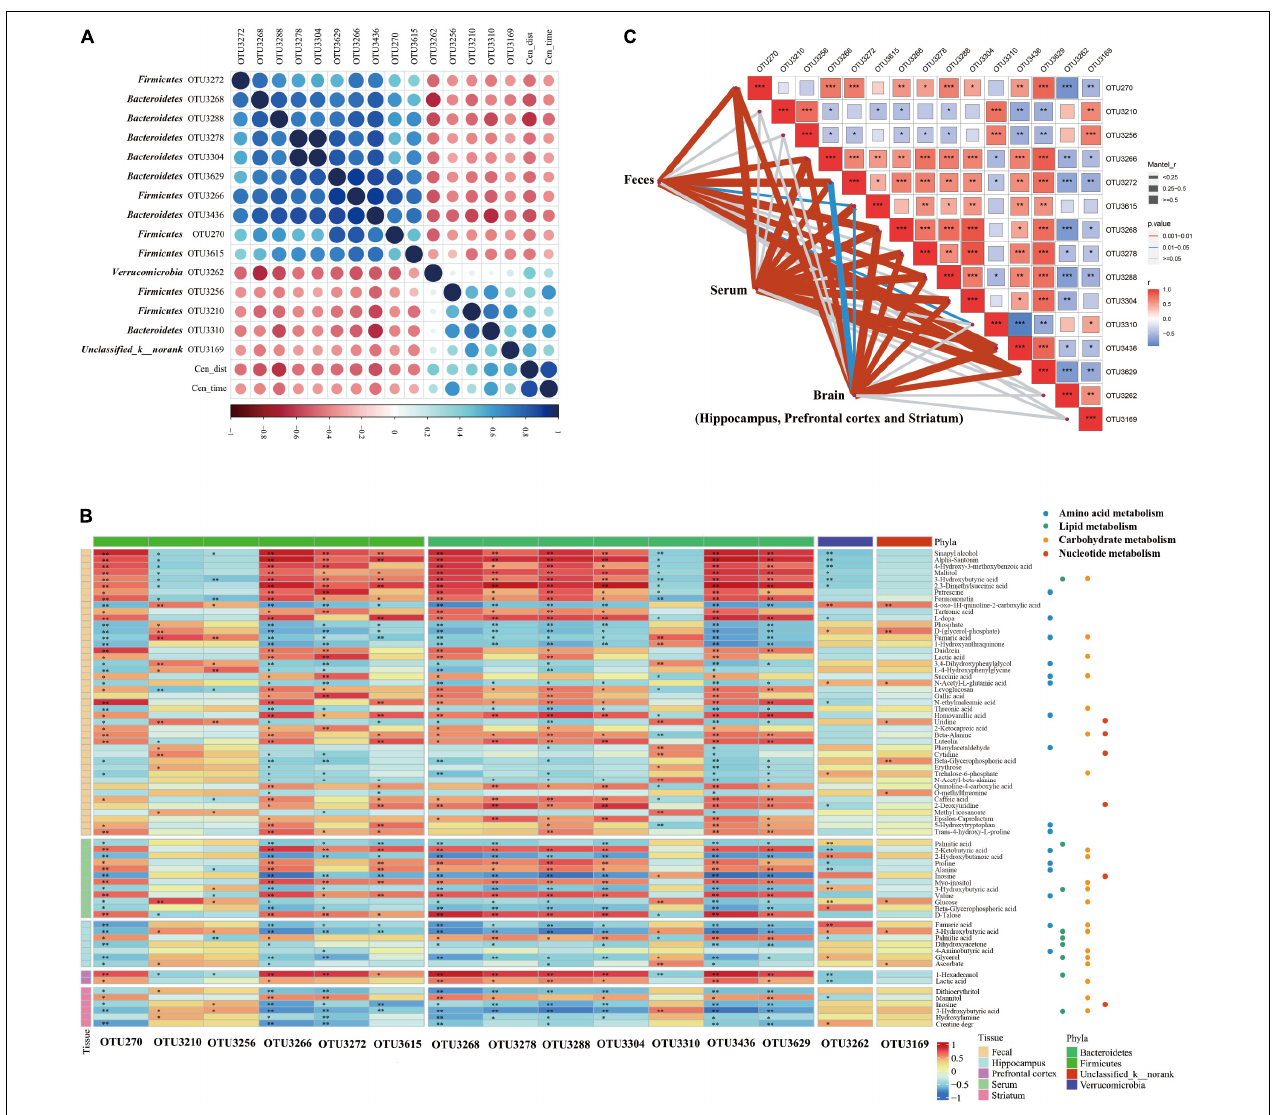
FIGURE 3 | Correlation between the abundance of reversed operational taxonomic units (OTUs) closely associated with anxiety-like behavior and reversed metabolites in the MGB axis. (A) Heatmap of correlation between the abundance of reversed OTUs and anxiety-like behavior. Fifteen OTUs were found closely related to anxious behavior, most of which were concentrated in Firmicutes (OTU270, OTU3210, OTU3256, OTU3266, OTU3615, and OTU3272) and Bacteroidetes (OTU3268, OTU3288, OTU3436, OTU3278, OTU3304, OTU3629, and OTU3310). Verrucomicrobia (OTU3262) and Unclassified_k_norank (OTU3169) were also involved. (B) Heatmap of correlation between the abundance of reversed OTUs closely associated with anxiety-like behavior and reversed metabolites in MGB axis. Reversed metabolic substances had a strong or weak association with reversed gut microbes, although significance was not reached for all. * P < 0.05, ** P < 0.01. (C) Mantel test of the correlation between the abundance of reversed OTUs and the entire reversed metabolic status of the various components of the gut-brain communication. * P < 0.05, ** P < 0.01, *** P < 0.001.